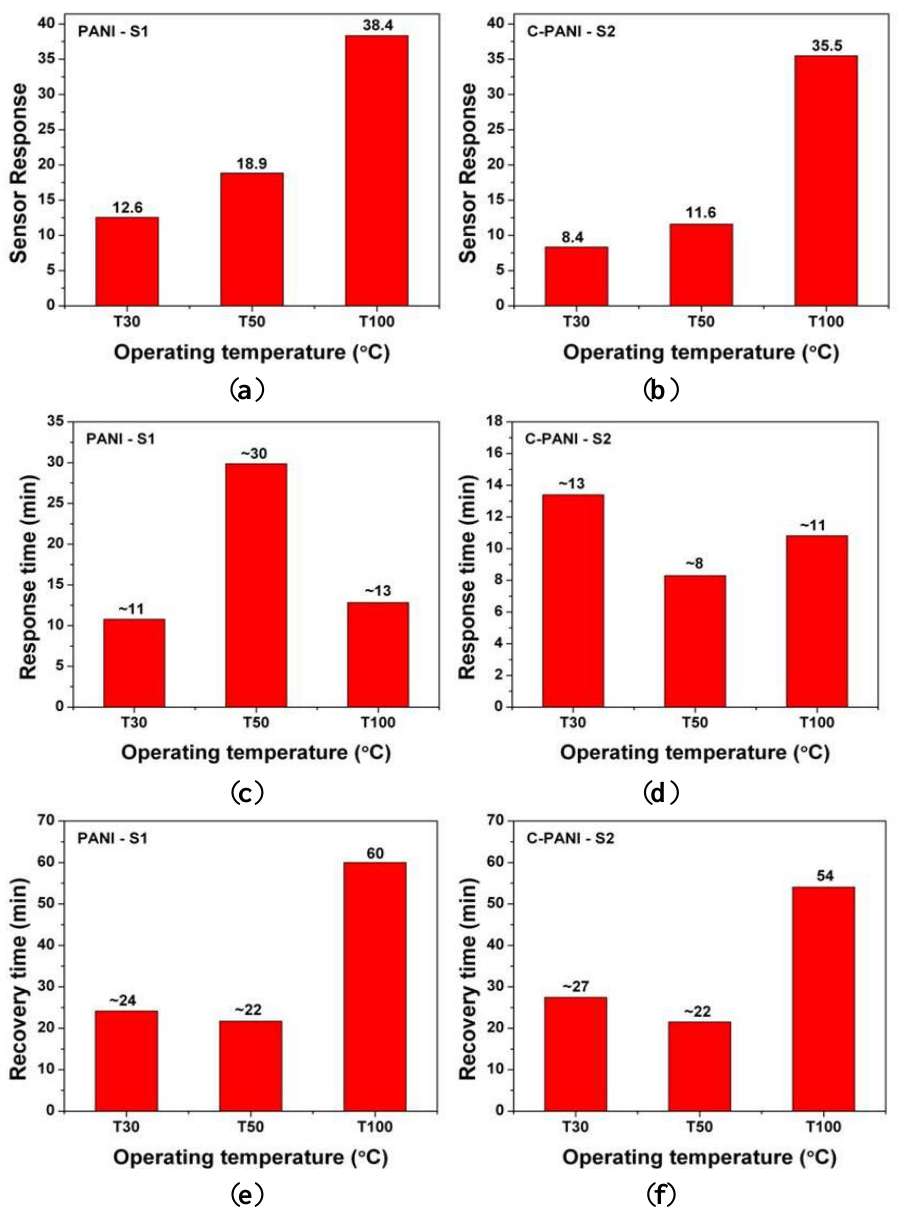
Figure 7. Toluene sensing behavior for PANI (S1) and C-PANI (S2) at different